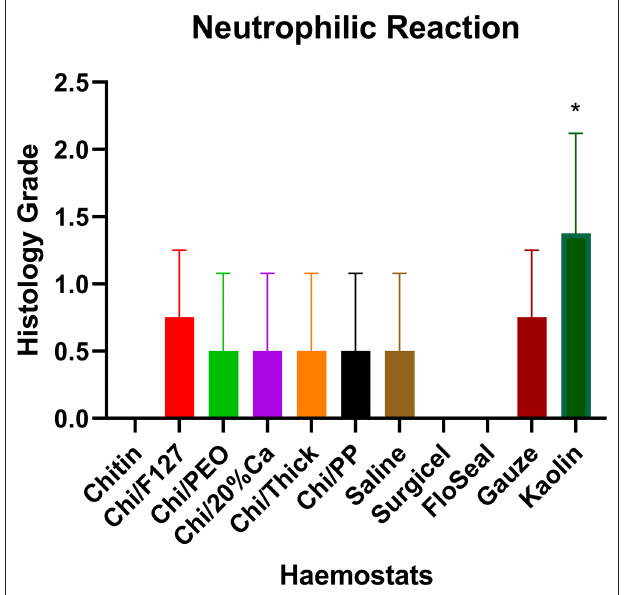
FIGURE 6 | Neutrophilic reaction seen with the application of modified and non-modified beta-chitin patches, Surgicel, FloSeal, Gauze and Kaolin (positive control) to rat brain. * p < 0.05 and compared to non-modified beta-chitin patch, analyzed by Kruskal-Wallis one-way ANOVA with Dunn’s test, n = 4.